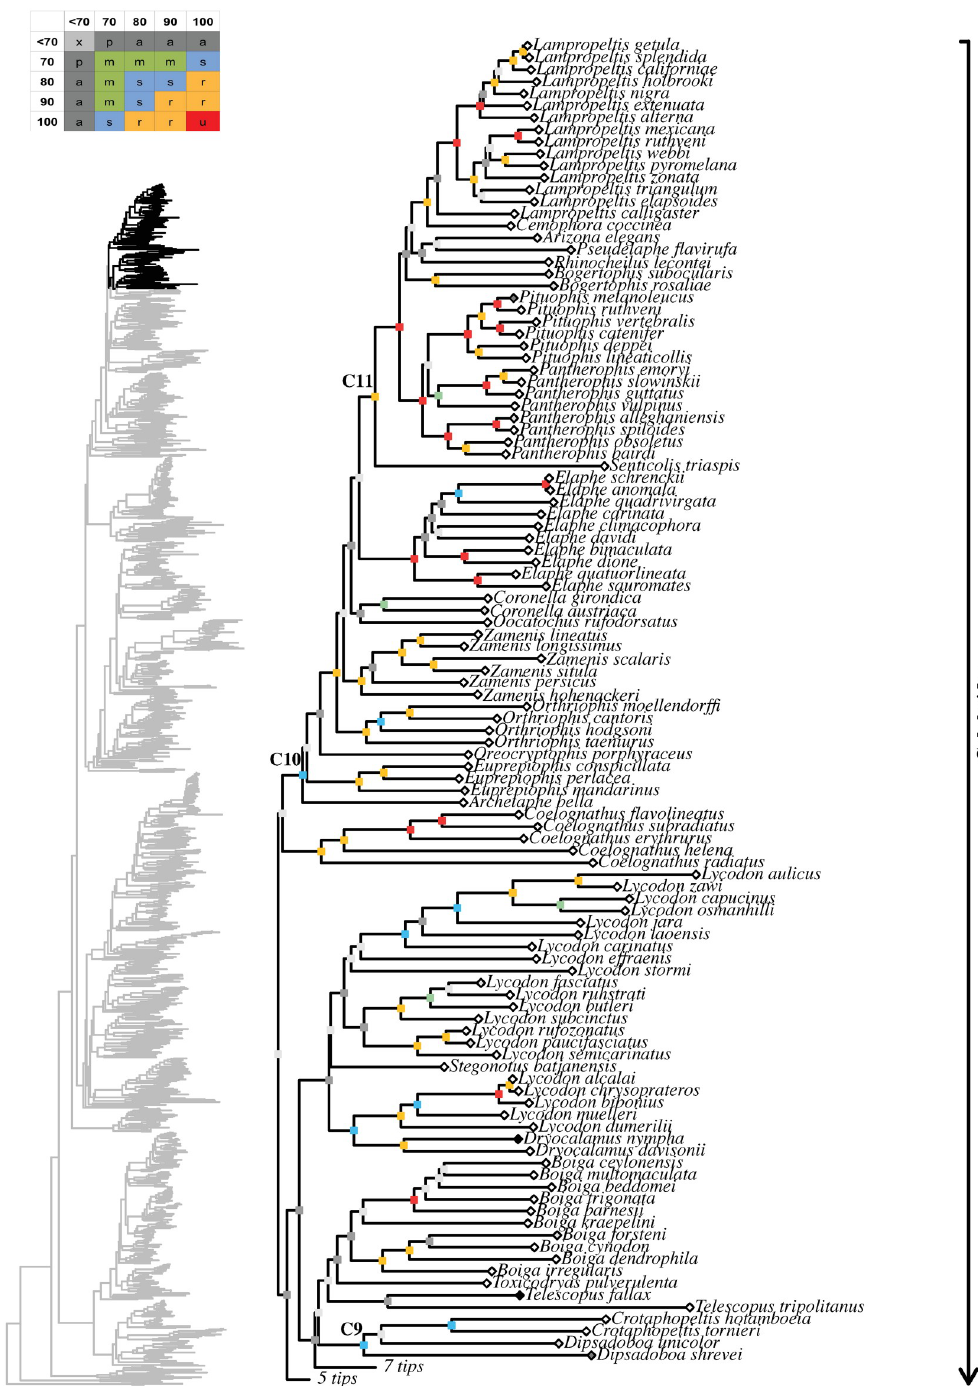
Fig 21. Maximum likelihood species-level phylogeny of Colubroides (continued). Family Colubridae (continued).